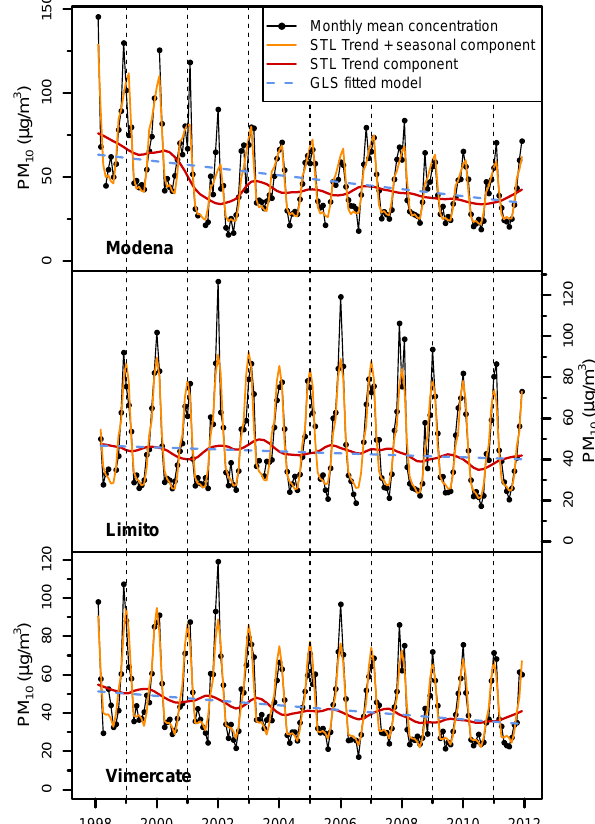
Figure 2. STL decomposition for monthly mean PM 10 along with GLS fitted slope for three selected